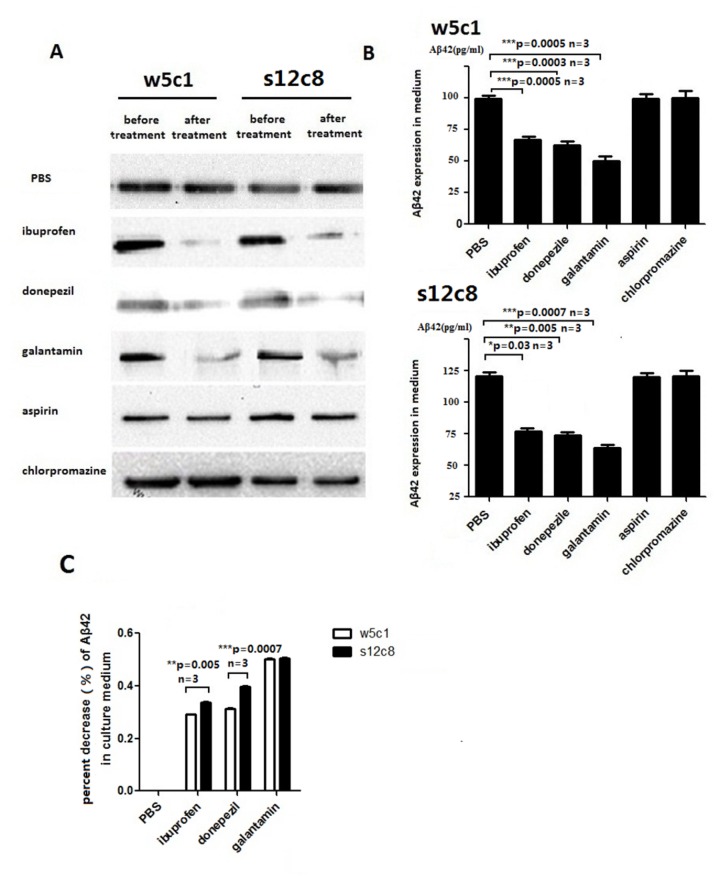
Changes in Aβ42 abundance in cell culture medium after drug treatment assayed by Western blot.(A) Western blot band intensity was used to measure differences in Aβ42 abundance in the cell culture medium of w5c1 and s12c8 cell after drug treatment. Representative blots are shown. Cells were treated with ibuprofen, donepezil, galantamin, aspirin and chlorpromazine. Results were obtained from three independent experiments, each performed in triplicate, and expressed as mean ± SEM. Error bars represent SE. (B) Quantification of the changes in Aβ42 levels between drug treatment groups. The release of Aβ42 into the cell culture medium was inhibited significantly by ibuprofen, donepezil and galantamin in both the w5c1 and s12c8 cell lines. Results are obtained from three independent experiments; each performed in triplicate, and expressed as mean ± SEM. Error bars represent SE. Asterisk indicates a statistically significant difference between two groups (P < 0.05). (C) Comparison of the effects of drugs on Aβ42 release into the cell culture medium by wildtype and mutant APP knock in cells. In ibuprofen and donepezil treatment groups, s12c8 exerted significantly greater sensitivity, compared to w5c1, to the drug treatments. Asterisk indicates a statistically significant difference between two groups (*p<0.05, **p<0.01, ***p<0.001).